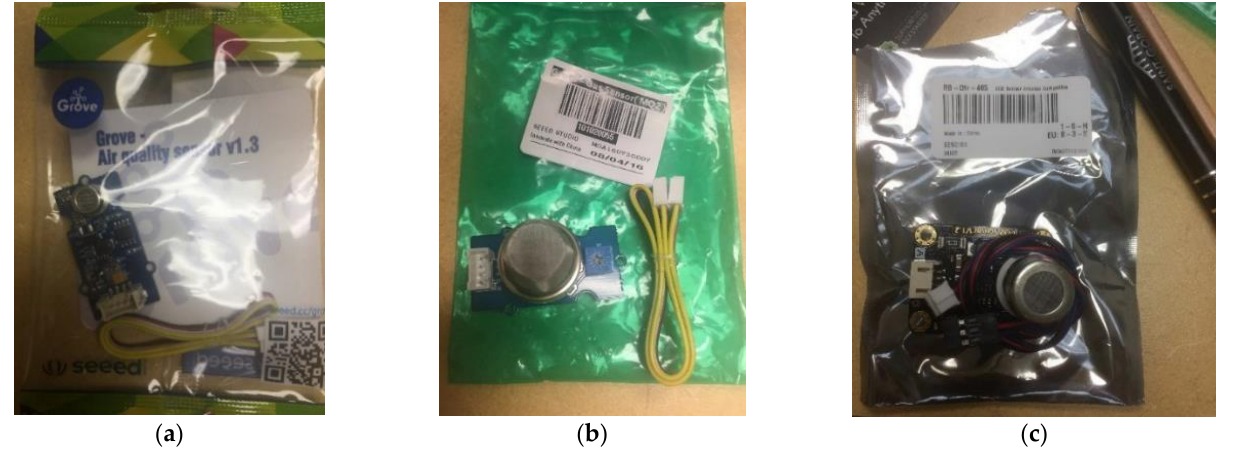
Figure 6. Sensors for indoor air quality: ( a ) air quality, ( b ) gas sensor and ( c ) VOC. Figure 5. Base station (Arduino system). ( a ) Arduino System assembled ( b ) Arduino System with the cover.